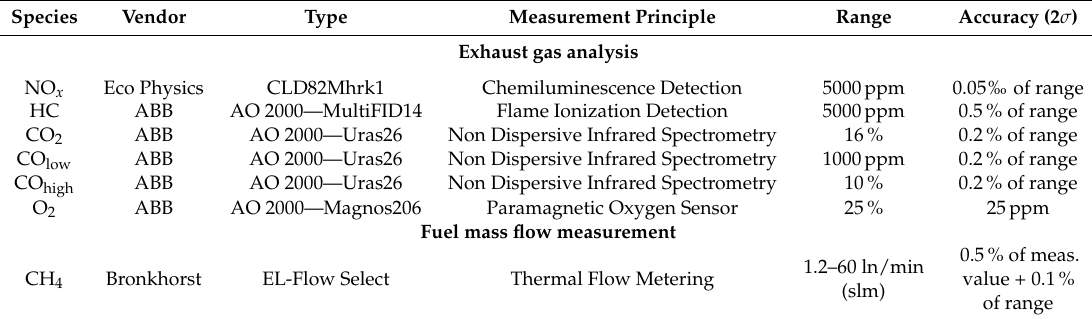
Table A1. Data of measurement